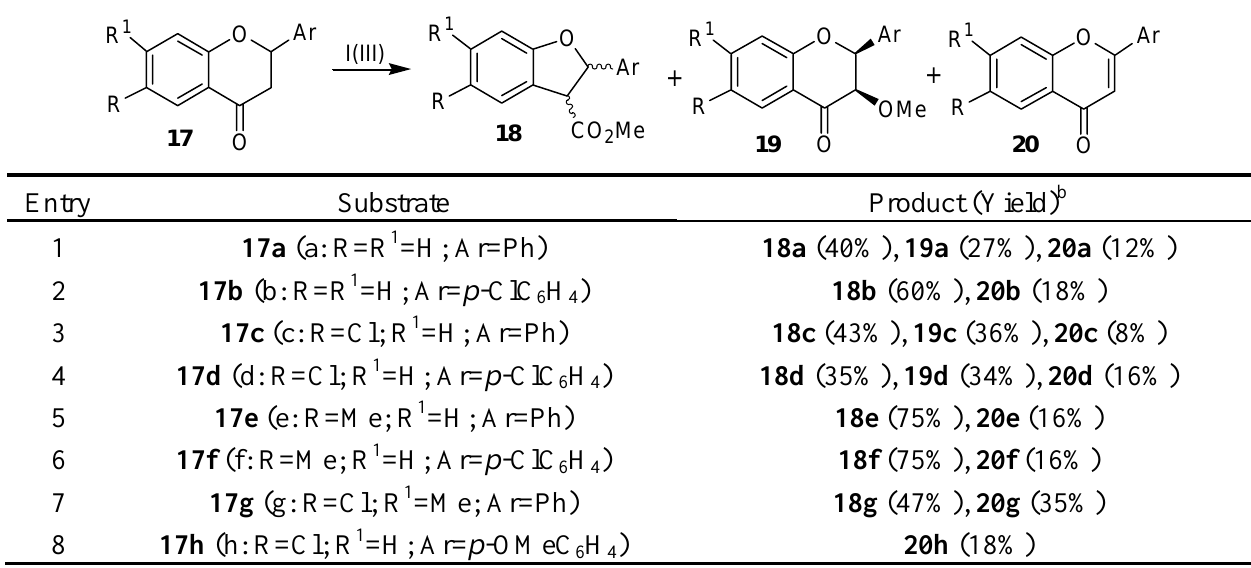
Table 1 . Reaction of Flavanones with Iodine(III) a